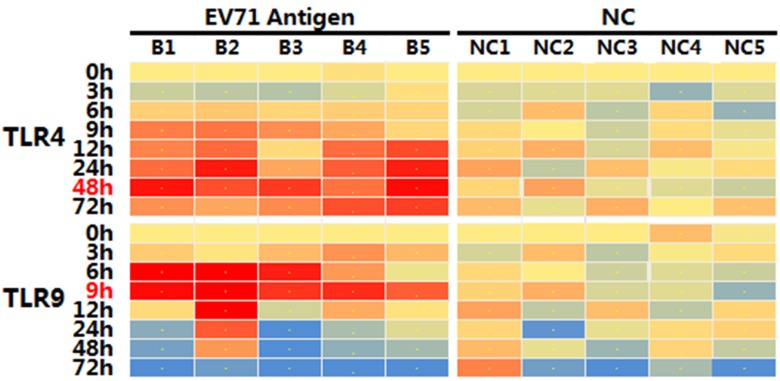
Heat map of TLR4 and TLR9 mRNA expression at different time points after incubation with EV71 inactivated liquid bulk in vitro.Each column in the graph represents a mouse (n = 5 per group), and colors ranging from blue to red corresponds to the fold change of the TLR4 or TLR9 mRNA expression after incubation with 100U/ml EV71 inactivated Ag. Medium was used as negative control and incubated with spleen lymphocytes similarly. The TLR4 mRNA expression peaked at 48h after incubation, while TLR9 peaked at 9h for most samples.